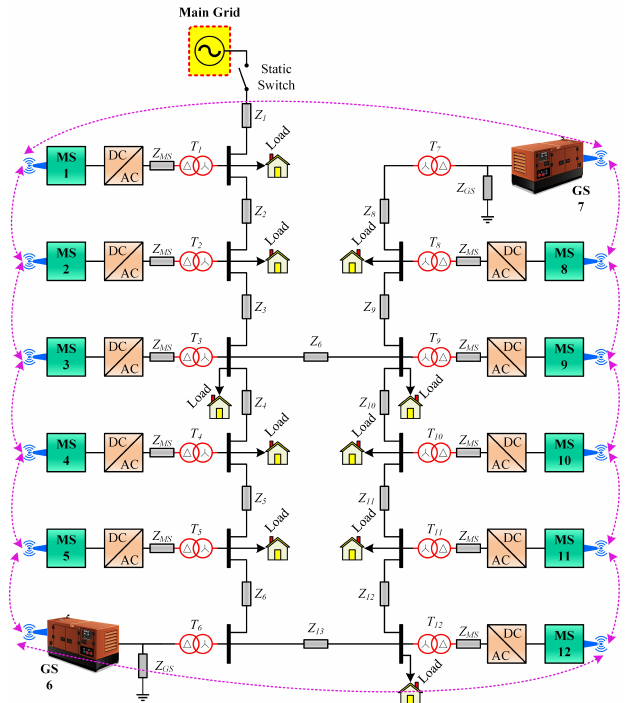
Figure 15. Large